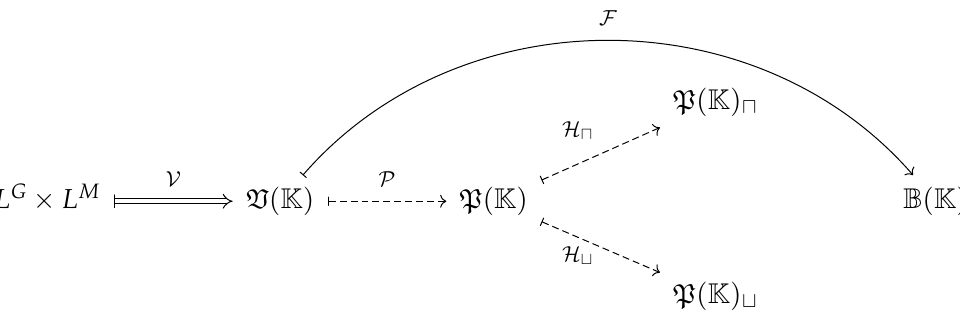
K ) B ( K ) (cid:117) , P ( (cid:116) , and the set of formal concepts,